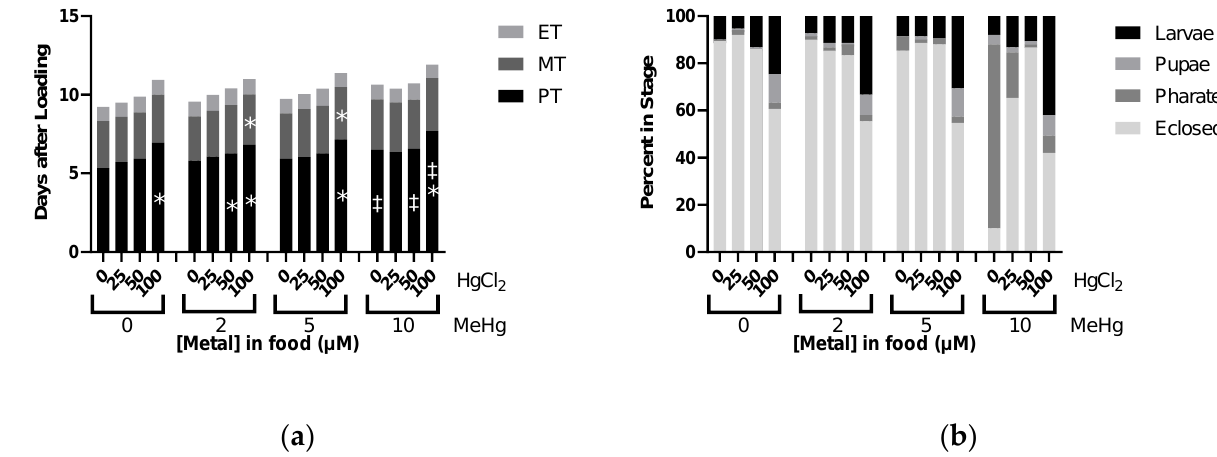
Figure 6. Effects of MeHg and HgCl 2 mixtures on Developmental Time Course. All data from same experiment using CS larvae dosed with indicated concentrations of MeHg and HgCl 2 in food. ( a ) Developmental Timing: average time spent in each stage across different treatment conditions. ( b ) Developmental Endpoints: average of individuals remaining in each stage of development at endpoint of 16 days. (* p < 0.05 compared to fixed value of MeHg at 0 µM HgCl 2 , ‡ p < 0.05 compared to fixed value of HgCl 2 at 0 µM MeHg, two-way ANOVA)